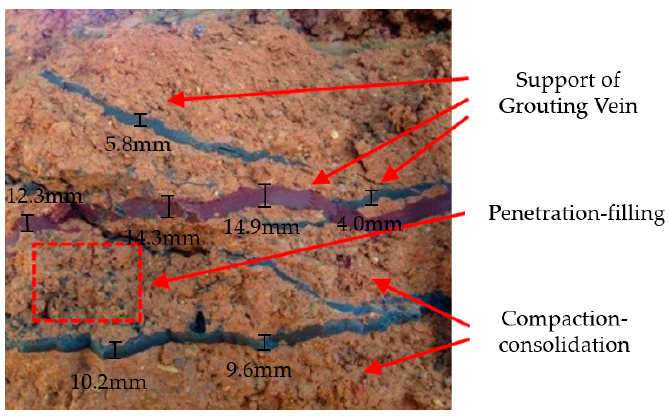
Figure 8. Cross ‐ grid grouting vein.